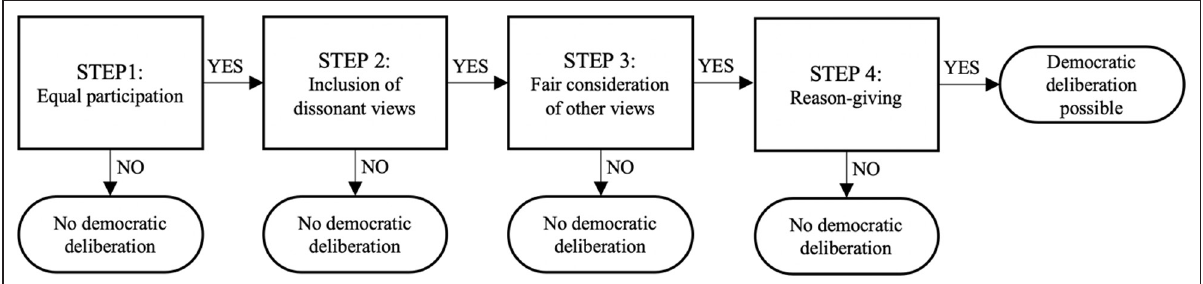
Figure 1: Multi-step model of high-quality deliberation in everyday political